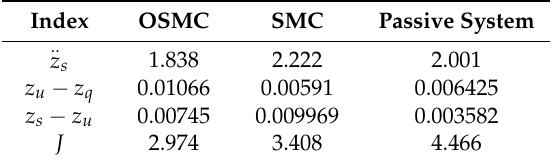
Table 4. Comparisons of three systems about performance indexes.